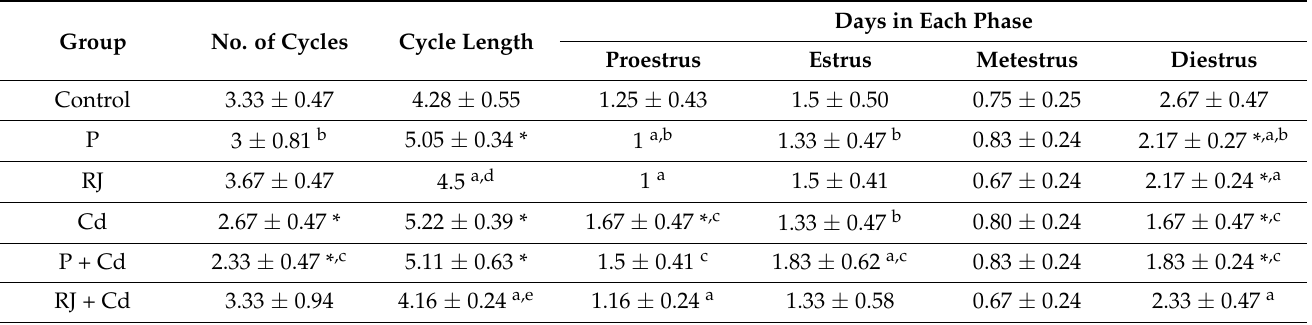
Table 2. Phases of the estrus cycle and its length in the different treated